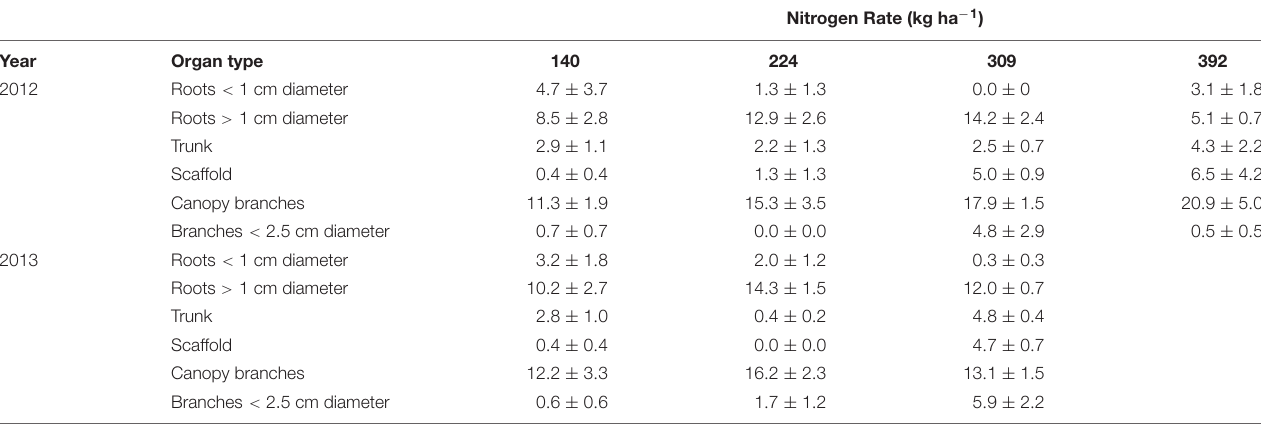
TABLE 5 | Nitrogen stored (kg ha − 1 ) in perennial tree organs (nutrient content when tree is dormant minus lowest nutrient content in perennial tissue during season) for almond trees with differential N application